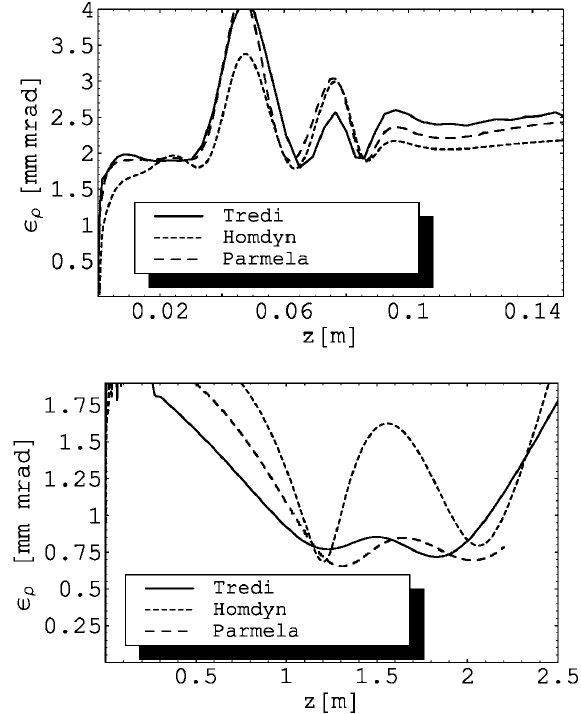
FIG. 10. Radial emittance in the rf gun (top panel) and over the full range (bottom